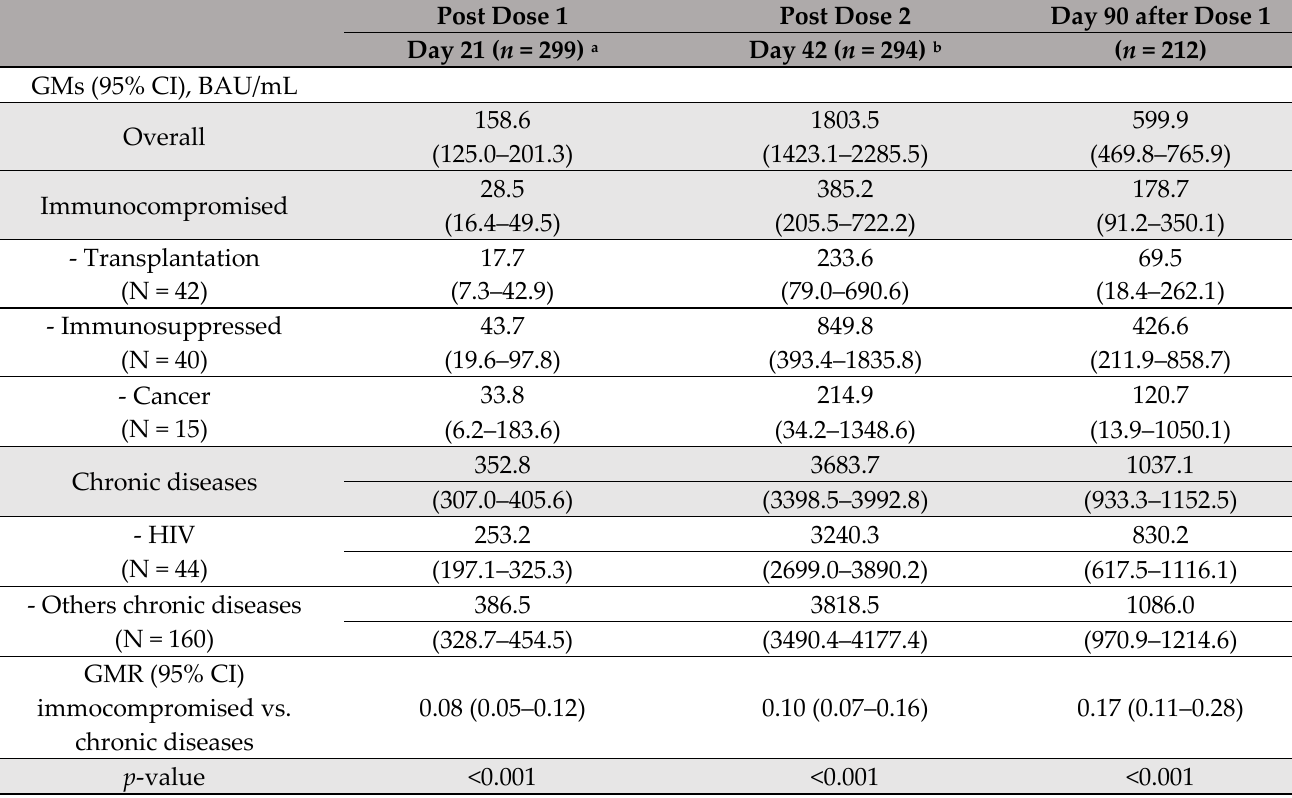
Table 3. Anti-receptor binding domain IgG (Anti-RBD IgG) after BNT162b2 vaccination among adolescents with chronic diseases.